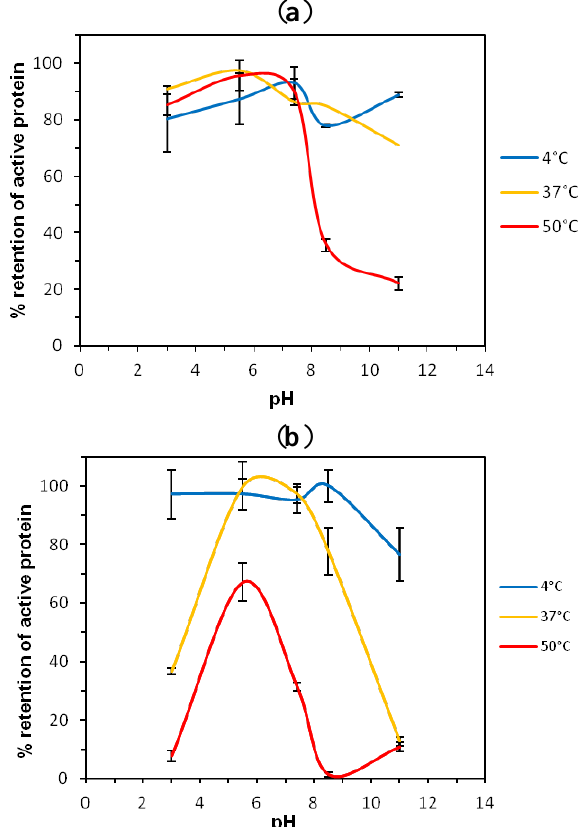
Figure 1. Retention of active variable new antigen receptor Variable New Antigen Receptor (V ) 4A-1 protein following heating at various pHs and temperatures ( a ) for 1 day and NAR ( b ) for 4